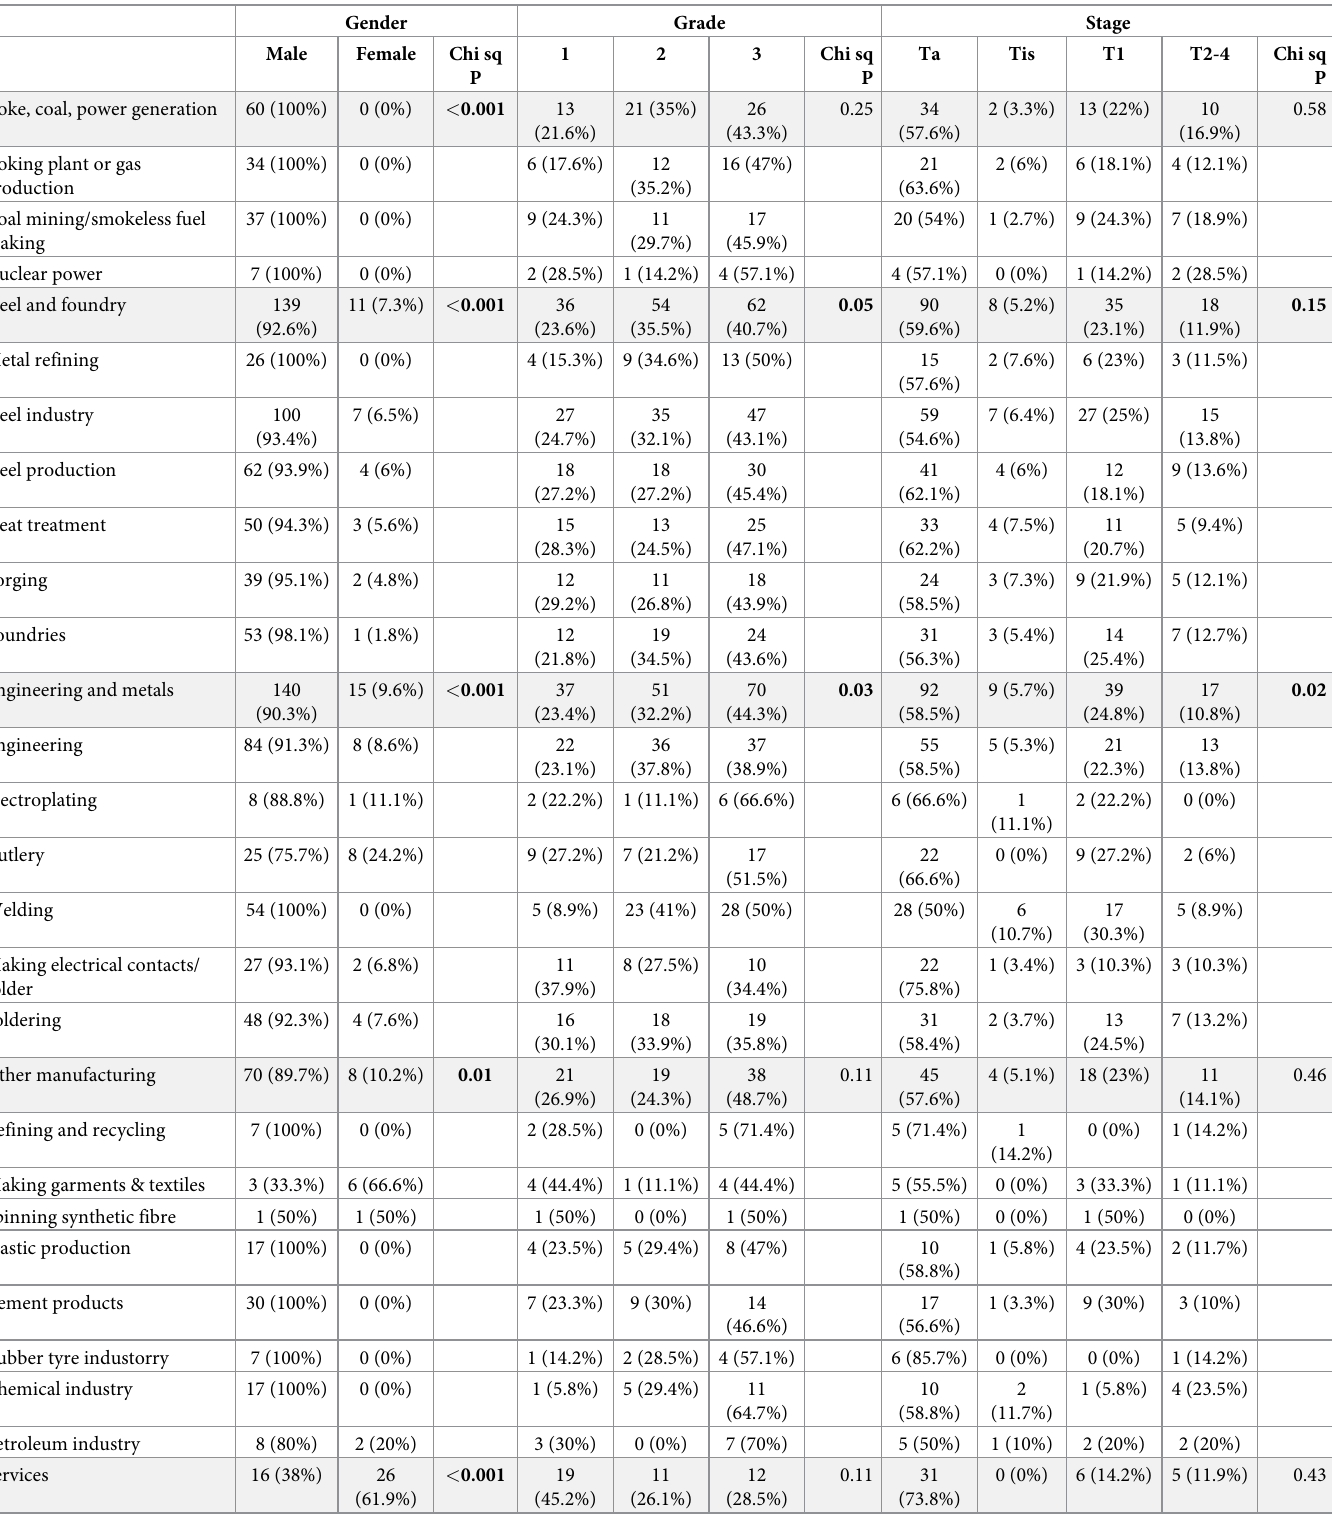
Table 2. Occupational class compared to patient sex and tumour